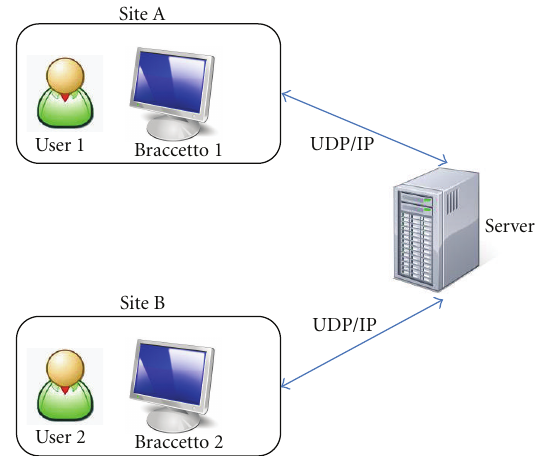
Figure 6: Diagram of the system